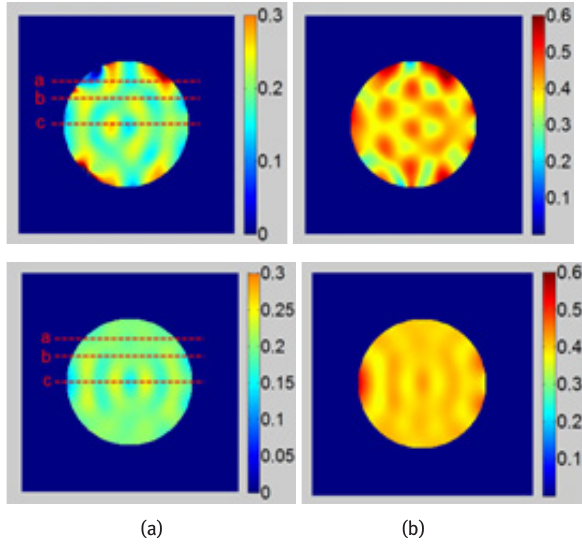
Figure 4: Top: Strain maps obtained with original image, Bottom: Strain maps obtained after DC component subtraction, (a) E